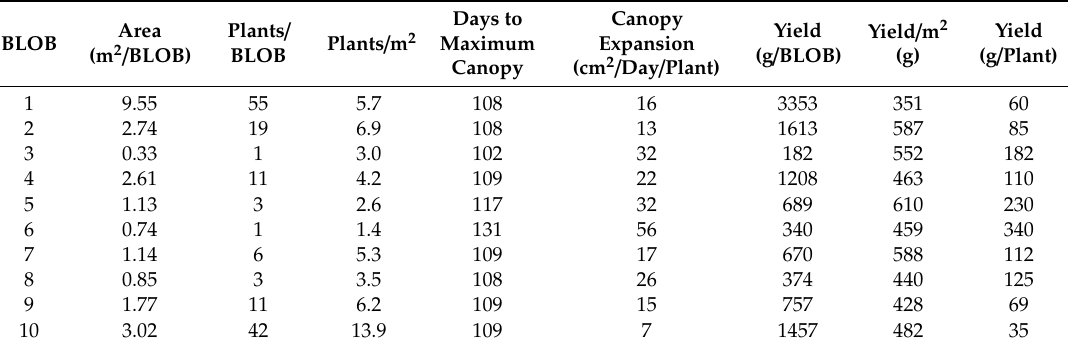
Table 3. Targeted analysis of BLOBs in planting